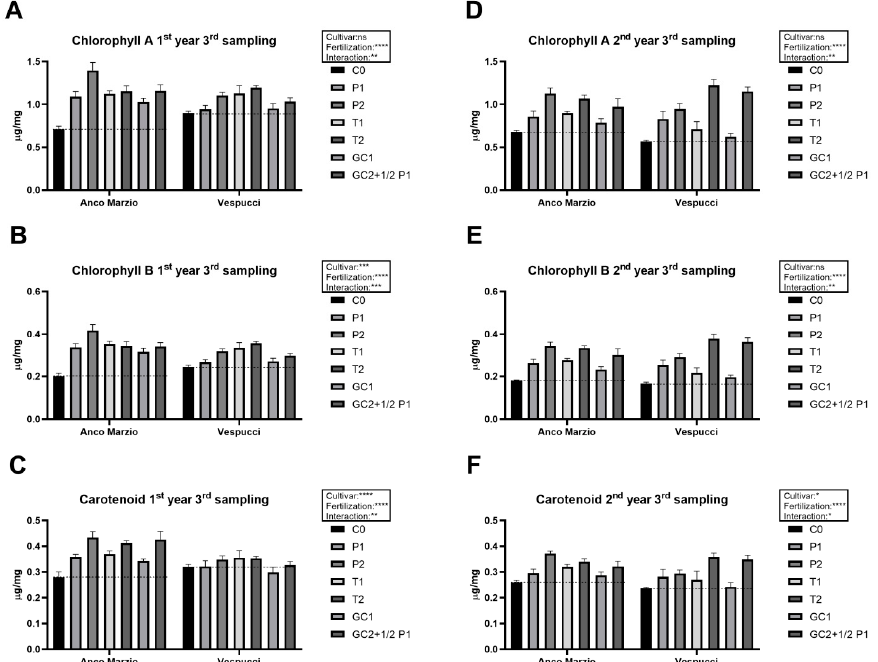
Figure 7. Pigment (Chlorophyll A, B, and Carotenoid) content on samples collected during the third crop stage (kernel ripening). Data are related to the first ( A – C ) and second ( D – F ) year of analyses. Data were reported by indicating the statistical significance of two factors (Cultivar and Fertilization) and their interaction. Data are reported with p -values. * p ≤ 0.05; ** p ≤ 0.01; *** p ≤ 0.001; **** p ≤ 0.0001; ns: